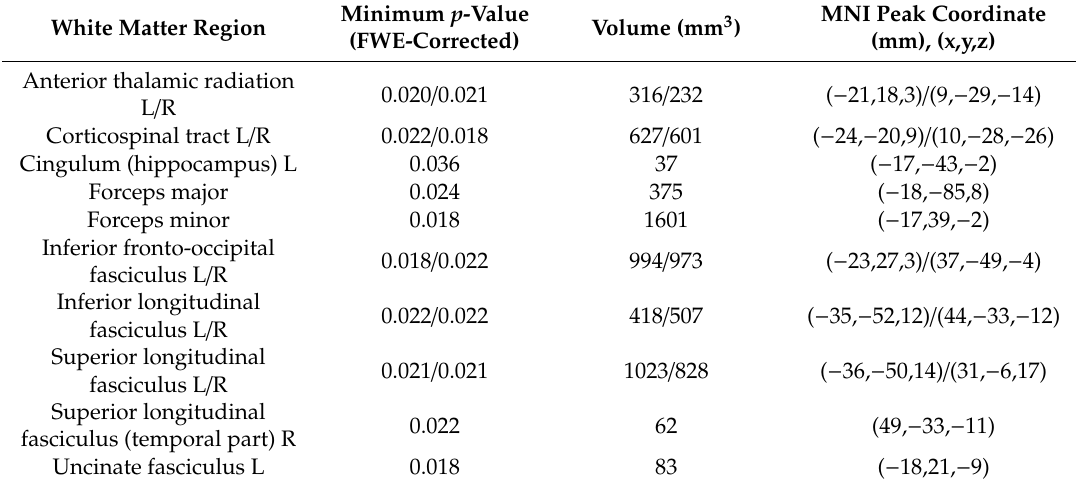
Table 3. White matter regions where significant decreased AD values were found in CM compared to EM using the White Matter Tractography